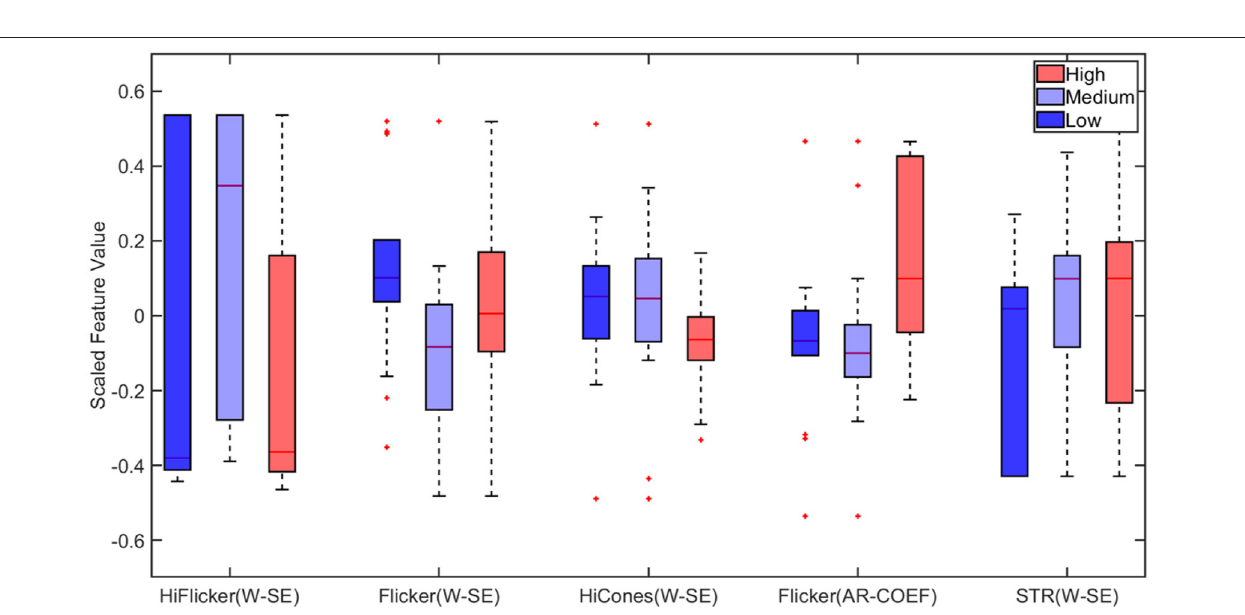
FIGURE 9 | Boxplot of wavelet-based features selected by Minimum Redundancy and Maximum Relevance (MRMR) feature selection algorithm for multiclass classification. STR, Scotopic Threshold Response; W-SE, Wavelet based Shannon Entropy; AR-COEF, Autoregressive Coefficient. On each box, the central mark indicates the median, and the bottom and top edges of the box indicate the 25th and 75th percentiles, respectively. The whiskers extend to the most extreme data points not considered outliers, and the outliers are plotted individually using the “+” marker symbol.